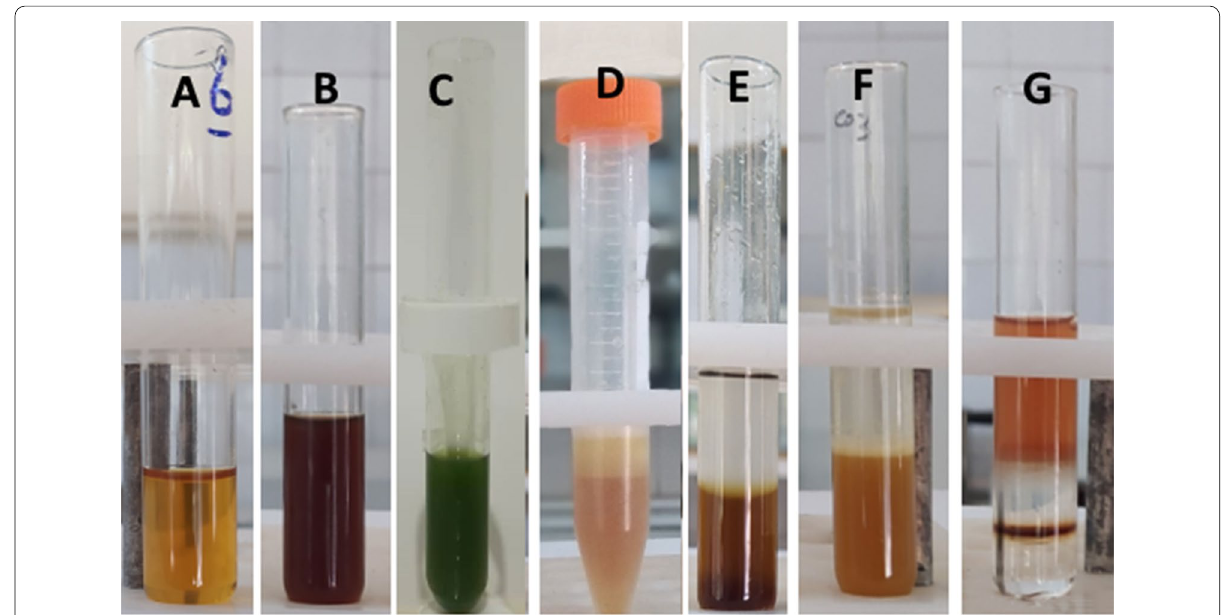
Fig. 1 Qualitative assay of phytochemical contents in MO extract. a Flavonoids, b terpenoids, c aglycone steroidal glycoside, d saponin, e polyphenols, g cardiac steroidal glycosides